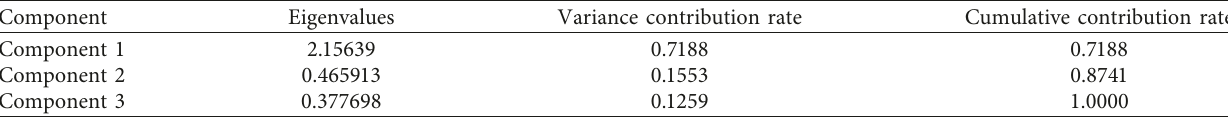
Table 3: Principal component explanation variance of gas pollutants.